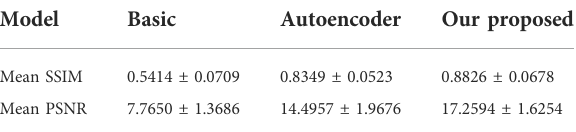
TABLE 4 PSNR and SSIM comparison.